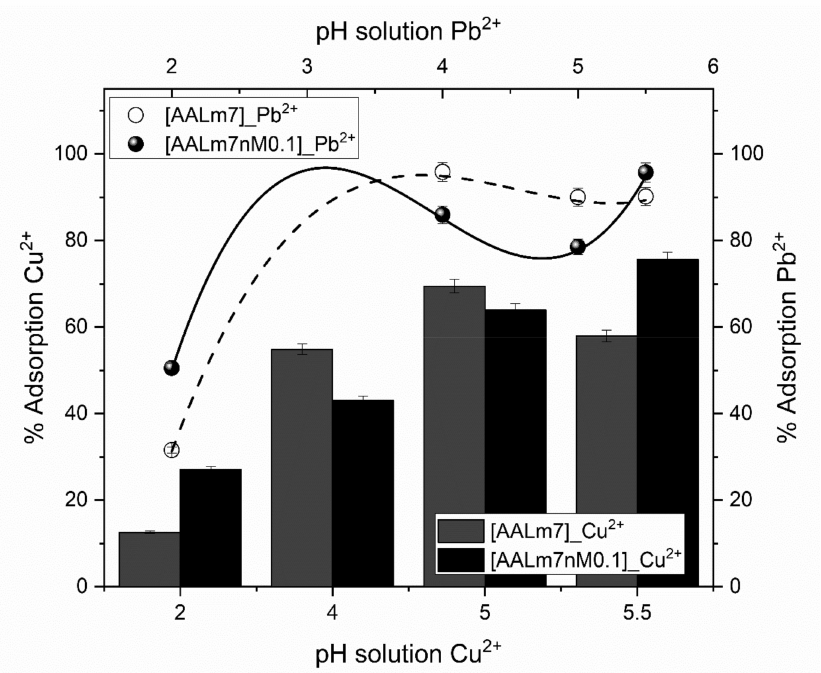
Figure 9. Removal percentage of Pb 2+ and Cu 2+ at different pH of the samples AALm7 and